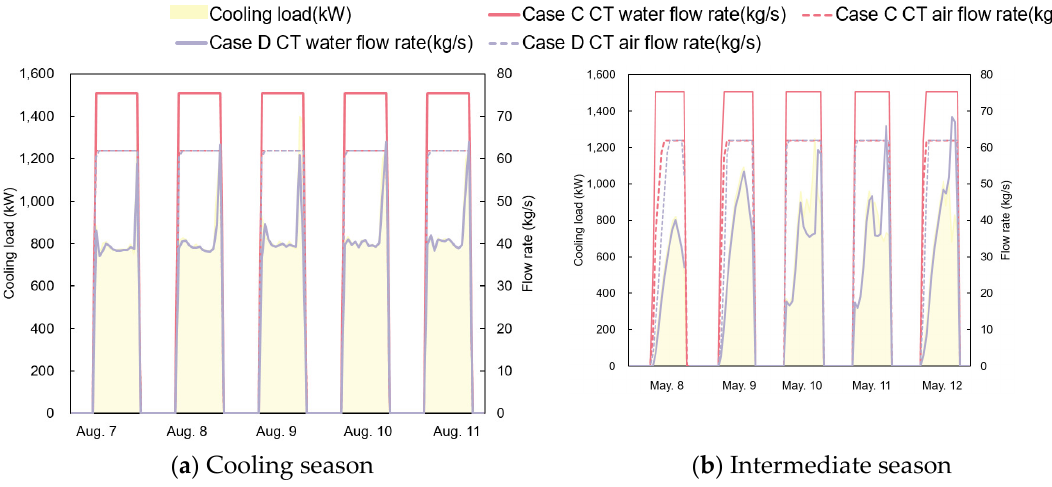
Figure 11. Weekly cooling tower air and water flow rate for Case C and D.